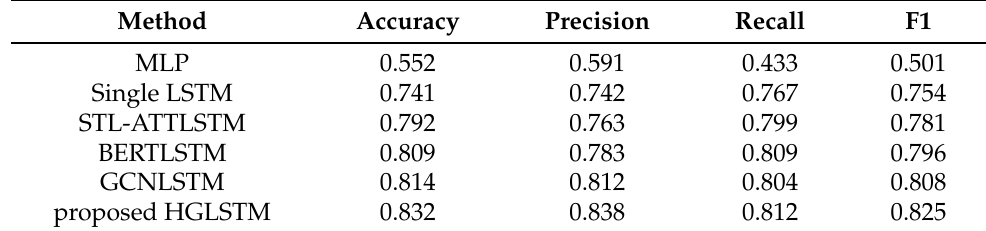
Table 2. Experimental results on our